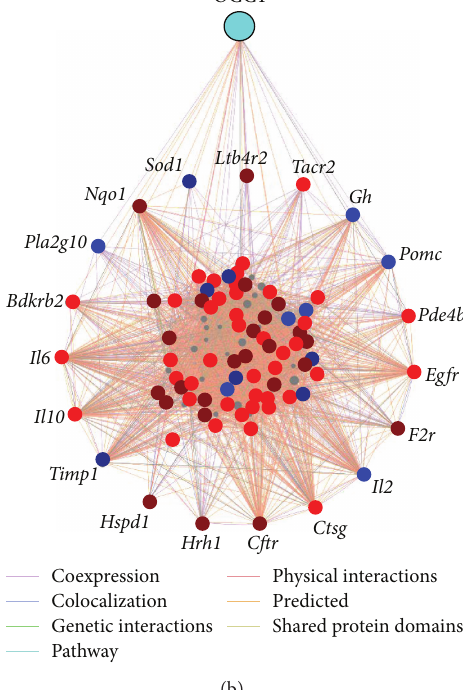
Figure 3: OGG1-BER induced gene expression associated with AHR. Mouse lungs received a single challenge (SC) or multiple challenges (MC) of 8-oxoG and were processed as previously described above. (a) Hierarchically clustered heat map was generated using GENE-E online software (Broad Institute, http://www.broadinstitute.org/) considering transcript levels (fold-change). Red represents upregulation and blue represents downregulation. (b) Enrichment network of the known and predicted interactions among the set of genes associated to airway hyperresponsiveness and OGG1. Peripheral nodes represent genes with a direct interaction with OGG1. The modified network was generated with GeneMania online database